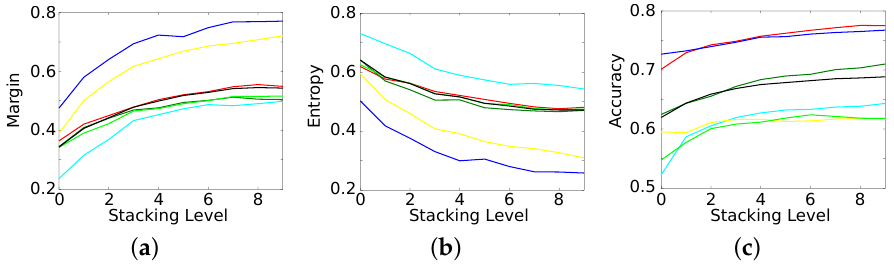
Figure 7. Results over the different stacking levels on the Berlin dataset. Colors denote different classes (see Figure 6b), black denotes the average over all classes. ( a ) Margin; ( b ) Entropy; ( c )